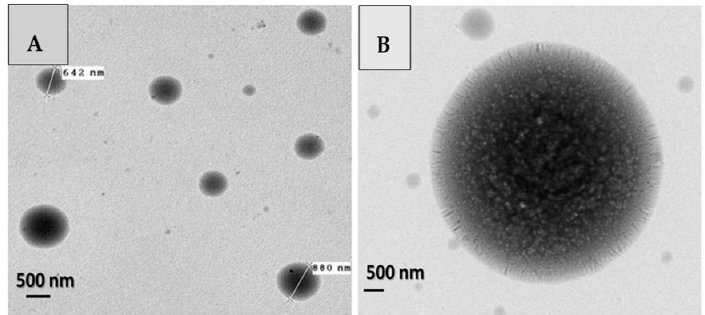
Figure 3. Examples of negative stain transmission electron microscopy (TEM) images of beads. Conditions of ethanol concentration and CaCl 2 concentration are: ( A ) 0.163 mL/h, 14 KV, 87.5% ethanol, 6.5% CaCl 2 ; ( B ) 0.163 mL/h, 14 KV; 100% ethanol, 15.5% CaCl 2 .